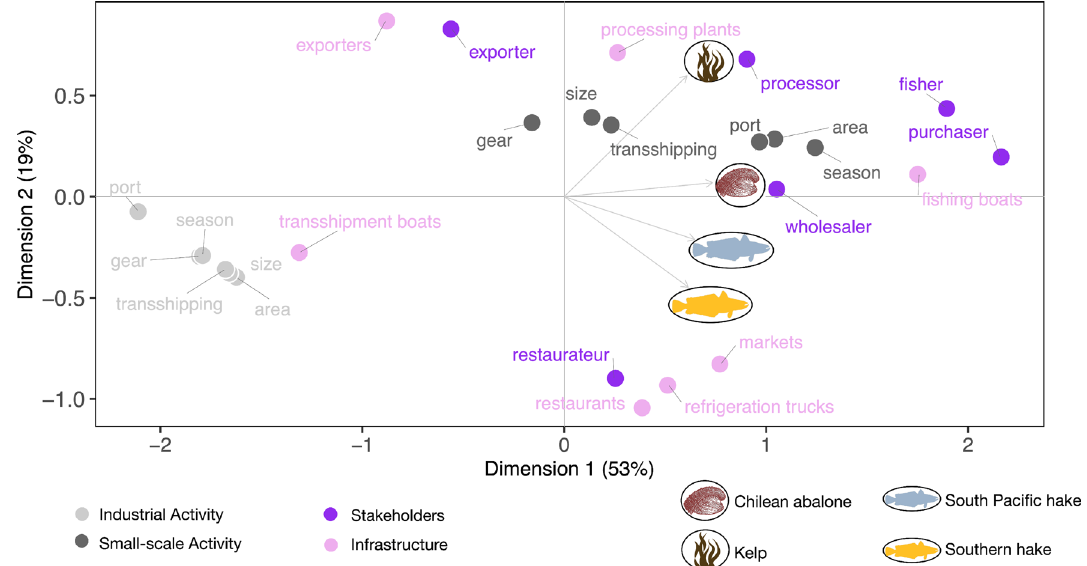
Figure 3. Principal Component Analysis (PCA) biplot of four focal fisheries and factors connected to illegality. The PCA score plot (colored circles) represents how the levels of each factor cluster (or not) across the two principal components, while the loading plot represents how each fishery is influenced by each principal component. Represented on the horizontal dimension, all the fisheries share the same high levels of small-scale activity (i.e., port, quota, and season) and stakeholders (i.e., fishers and purchasers). Represented on the vertical dimension, differences between the focal fisheries are revealed in the infrastructure and certain stakeholders. Factors connected to exportation and processing are closely connected to kelp illegality, while factors connected to retail (e.g., restaurants and markets) are closely connected to hake illegality. For all fisheries, industrial activities and transshipment boats are weakly associated with illegal